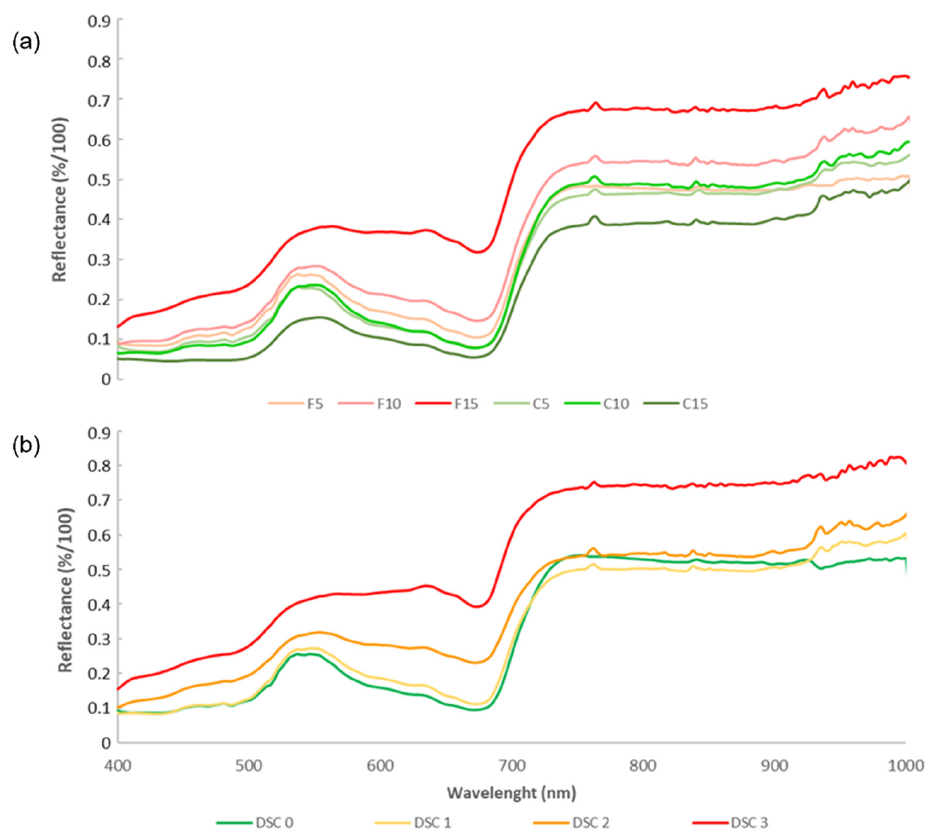
Figure 3. Hyperspectral reflectance signatures of wild rocket under progression of Fusarium wilting. Comparison of spectral curves of healthy© and FOR-infected (F) plants at 5, 10, and 15 dpi by using color gradients light to dark green and red, respectively (panel ( a )). Means of hyperspectral reflectance averages rearranged per level of disease severity class: Healthy, level 0 (DSC 0, green); mild stunting, level 1 (DSC 1, yellow); severe stunting and yellowing, level 2 (DSC 2, orange); and necrosis/dead plants, level 3 (DSC 3, red) (panel ( b